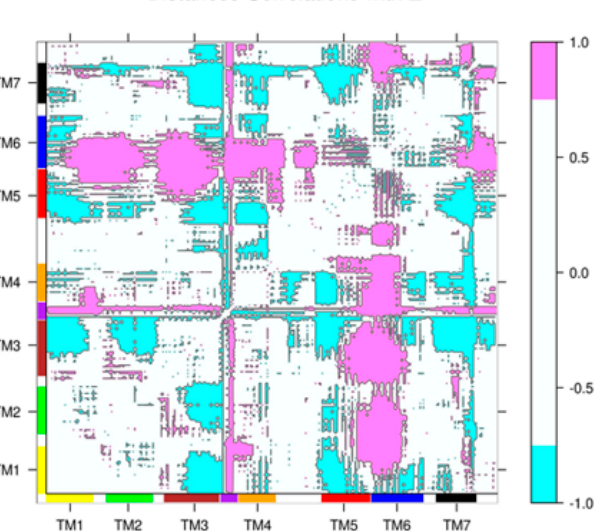
Figure 3. Matrix of correlations between inter-residue distances and ∆ for the ensemble of experi- mental structures of the β 2AR. Each element cij in this matrix is the correlation coefficient between ∆ and the distance between residues i and j. Only strong correlations (| cij | > 0.75) are shown. Positive correlations are in pink and anti-correlations are in cyan. Segments corresponding to transmembrane helices are indicated by color rectangles on the margins of the figure (ICL2 is represented by the purple rectangle between TM3 and TM4).